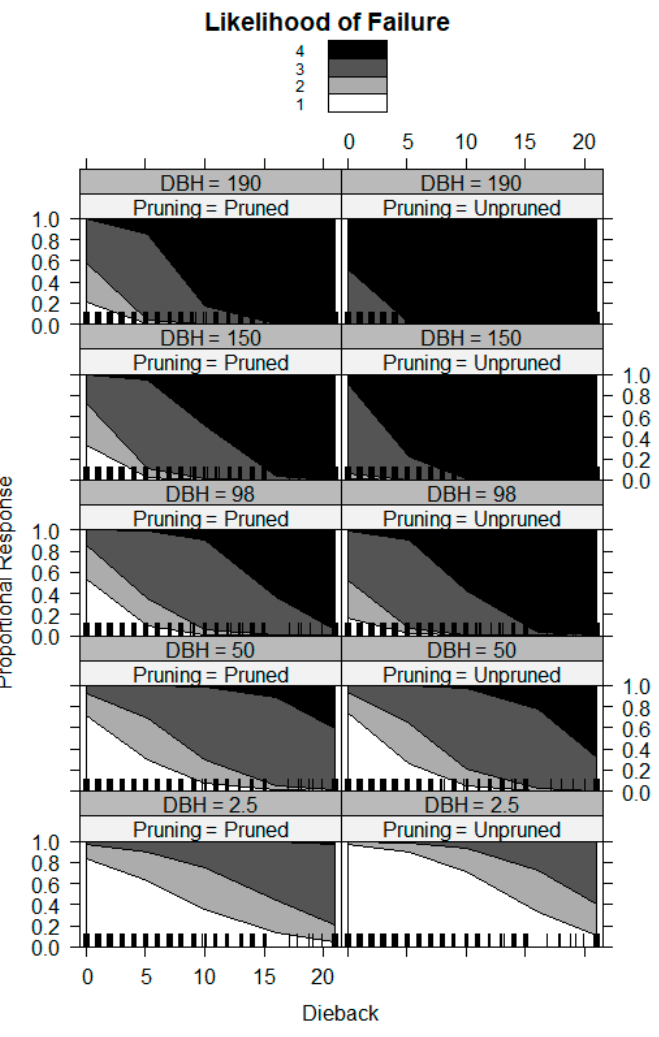
Figure 5. Visualization of the ordinal linear regression model to illustrate the effect of pruning status (pruned or unpruned), diameter 1.4 m above ground (DBH, cm), and percent crown dieback on the proportional response of assessed likelihood of failure. Numerical likelihood of failure values 1, 2, 3, 4, correspond to categories “improbable”, “possible”, “probable”, and “imminent,”, respectively, from Smiley et al. (2017). Note z below Table 3 describes percent crown dieback.